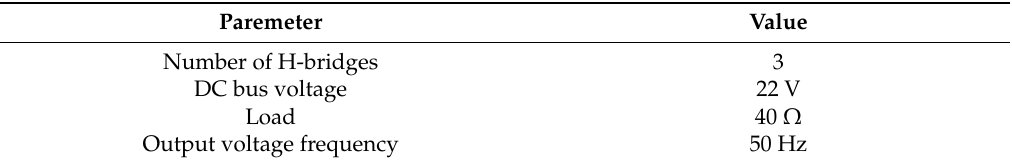
Table 8. Key parameters of the